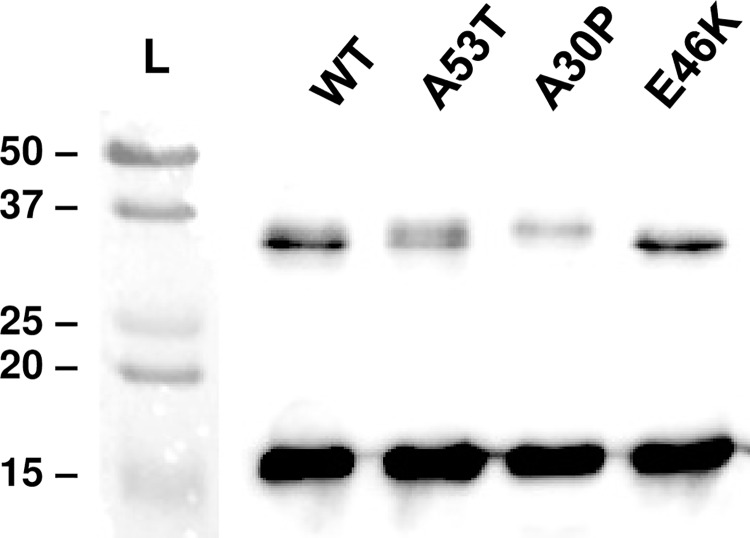
Analysis of α-synuclein preparations.Representative Western Blot of α-synuclein proteins (wild-type and mutants) separated by a 12% non-denaturing gel electrophoresis and probed with monoclonal antibody 4D6. Wild-type α-synuclein (WT), A53T, A30P and E46K mutant proteins were prepared at 2 μM. L = Ladder (kDa).